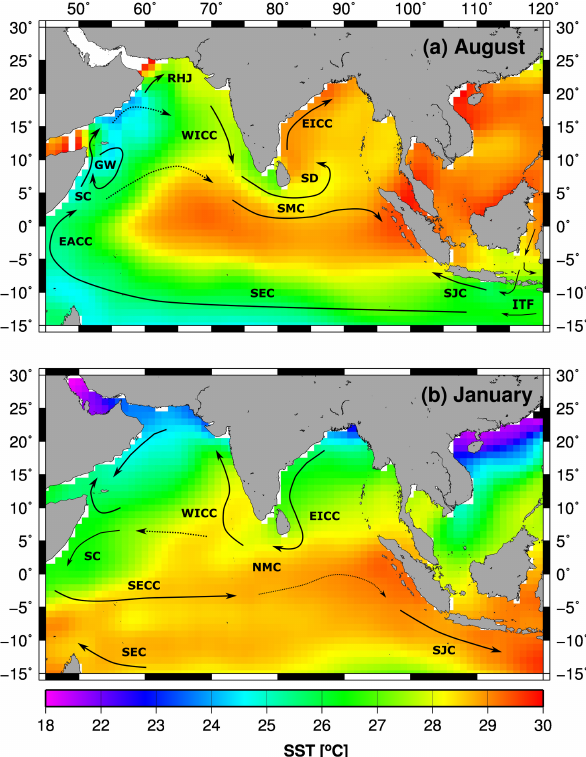
Figure 4. (a, b) Monthly mean sea surface temperature in the In- dian Ocean (Smith et al., 2008) and the surface ocean circulation simplified and redrawn from Schott and McCreary (2001). The ar- rows indicate the South Equatorial Current (SEC), South Monsoon Current (SMC), Sri Lanka Dome (SD), East Indian Coastal Current (EICC), South Java Current (SJC), Indonesian Throughflow (ITF), Somali Current (SC), Great Whirl (GW), Ras al Hadd Jet (RHJ), West Indian Coastal Current (WICC), and North Monsoon Current (NMC). The maps were produced with Generic Mapping